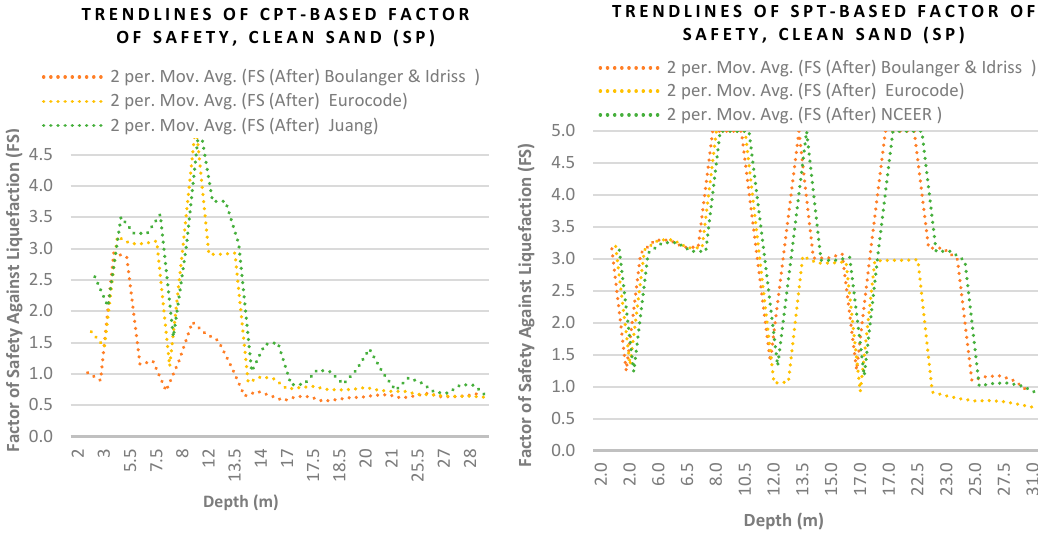
Figure 11. Comparison of the factor of safety values based on two-point moving averages, according to three CPT-based method ( left ) along with three SPT-based approaches ( right ) for assessing the improvement of the clean sand soil against the liquefaction, after jet grouting by micropiles.